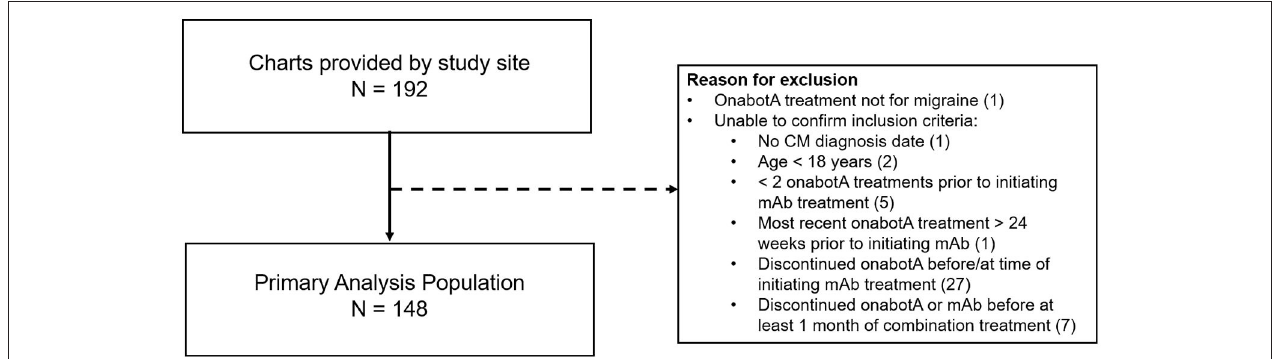
FIGURE 2 | Primary analysis population. mAb, monoclonal antibody; onabotA, onabotulinumtoxinA. In the case of multiple inclusion criteria unconfirmed, patient is included in the first ( n ) only. This pertains to 2 patients.